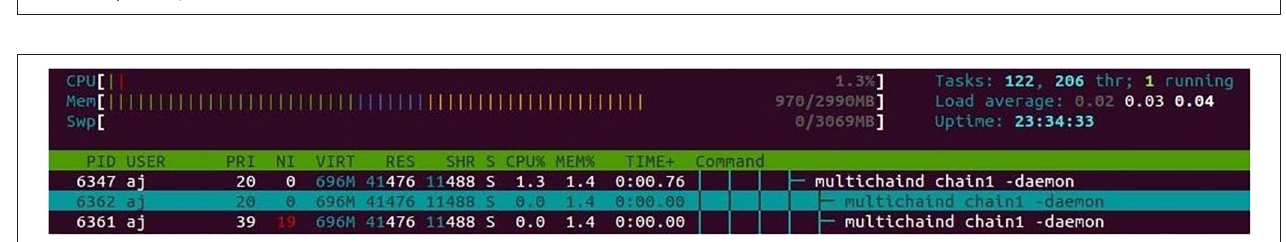
FIGURE 8 | Memory status at normal state.